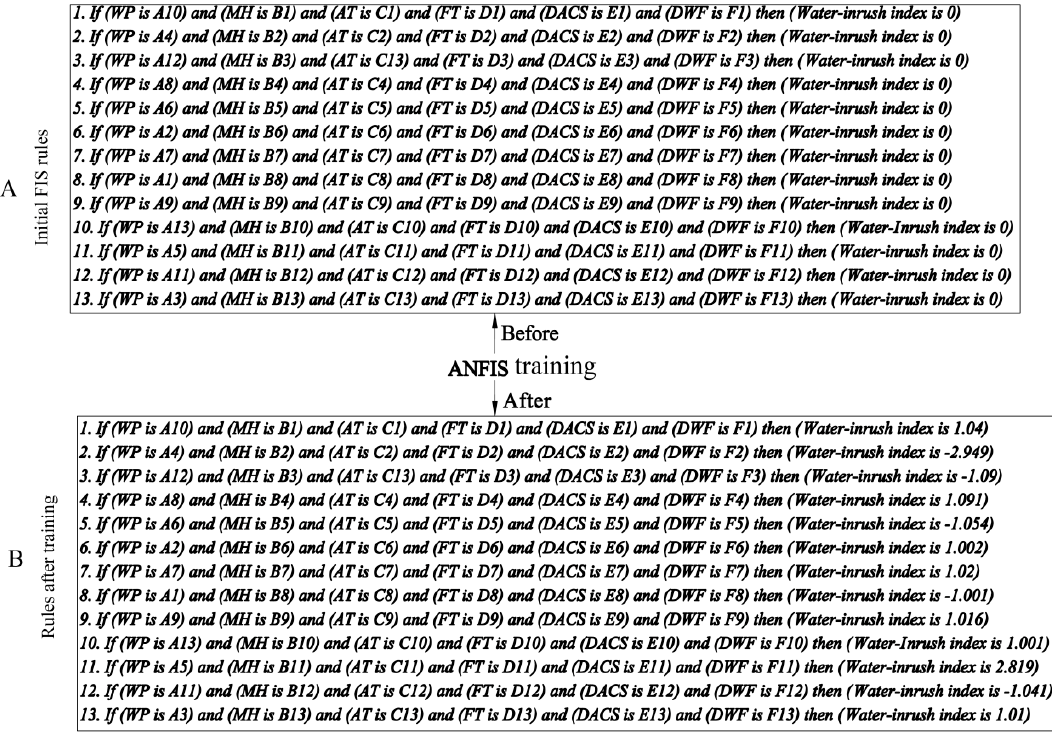
Figure 6. The initial fuzzy inference system (FIS) rules before training and after training. In this figure: ( A ) refers to the 13 initial FIS rules which are generated by using the subtractive clustering approach and ( B ) refers to the 13 trained FIS rules which are obtained by using the hybrid training algorithm.